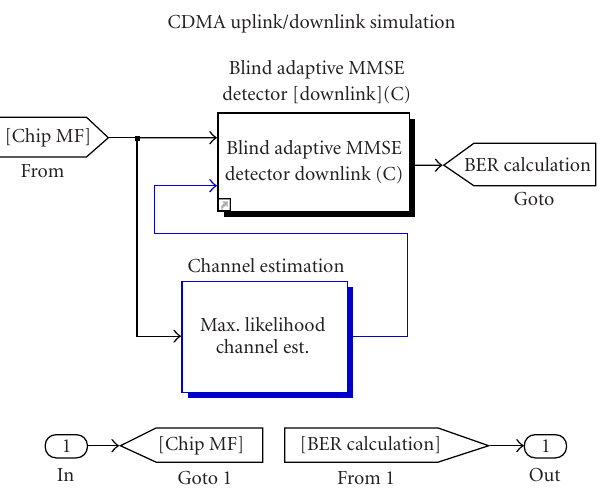
Figure 13: The DSP portion of the RENE CDMA testbed after sep- aration by the Switcher.